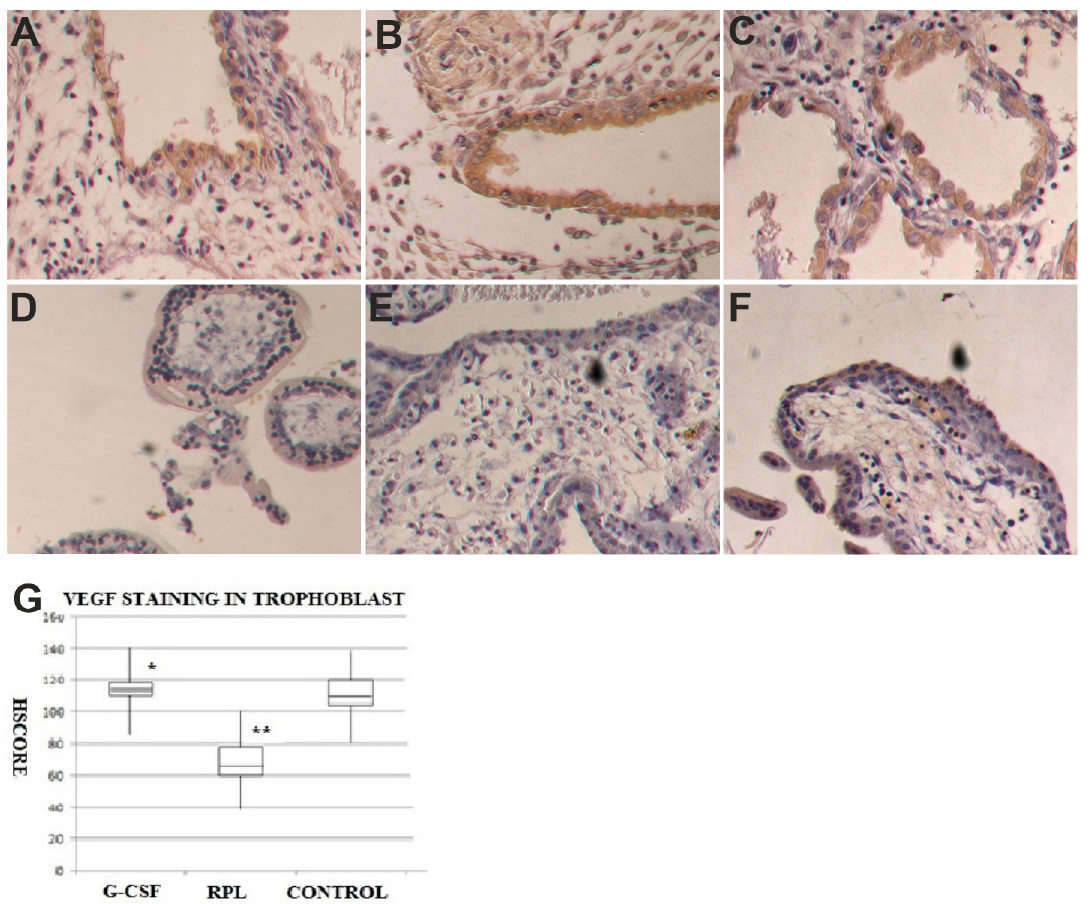
Figure 4. VEGF expression in decidua and trophoblast of first trimester pregnancy. In decidua of G-CSF treated group ( A ), in the no treated RPL group ( B ) and Control pregnancies ( C ) there was the same staining levels in the epithelial cells but no in the stroma for VEGF (brown color) (400 × ). In trophoblast of G-CSF treated samples ( D ), the syncytiotrophoblast was strongly positive to VEGF (brown color) (400 × ). In trophoblast of RPL no treated samples ( E ), the syncytiotrophoblast was weakly positive to VEGF (400 × ). In trophoblast of Control samples ( F ), the syncytiotrophoblast was strongly positive to VEGF (brown color) similar to G-CSF treated samples (400 × ). The graph ( G ) showed immunohistochemical staining semi quantitative HSCORE for VEGF (Charts display median and quartiles with whiskers showing the range): There was a statistically significant di ff erences between G-CSF vs. RPL (* p < 0.001) and RPL vs. Control (** p < 0.001).